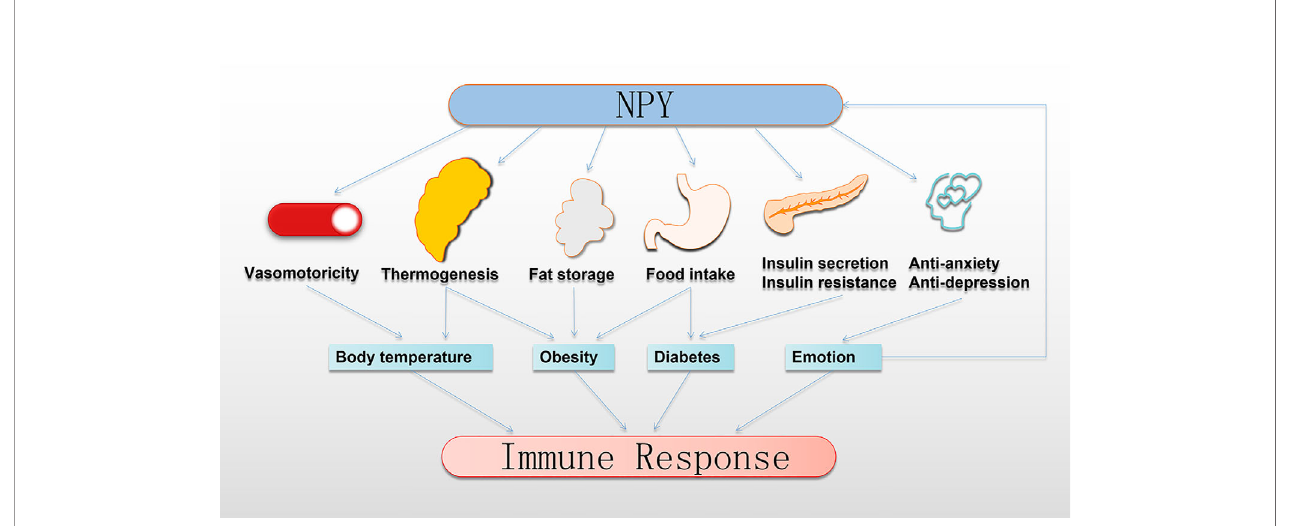
FIGURE 3 | NPY indirectly regulates the immune response. NPY regulates thermoregulation, obesity, and development of diabetes by controlling the vasomotor of the skin, thermogenesis of BAT, fat storage in WAT, food intake, insulin secretion, and insulin resistance. Moreover, NPY plays anti-anxiety and anti-depression roles to transform emotional expression. Interestingly, this regulation by NPY profoundly impacts the immune response. BAT, brown adipose tissue; NPY, neuropeptide Y; WAT, white adipose